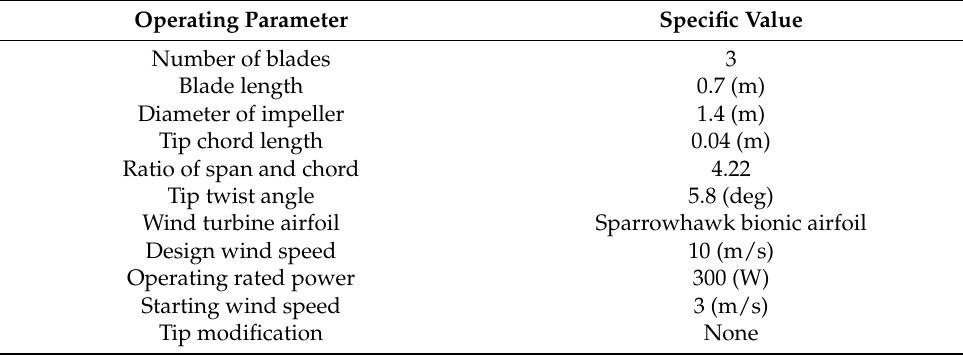
Table 1. Operating parameters for the design wind turbine impeller.